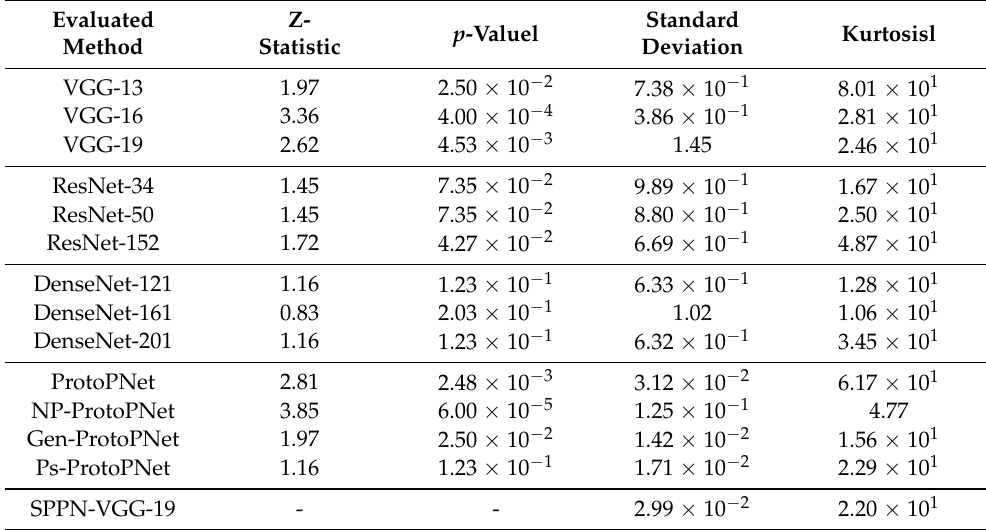
Table 5. Statistical results for the evaluated